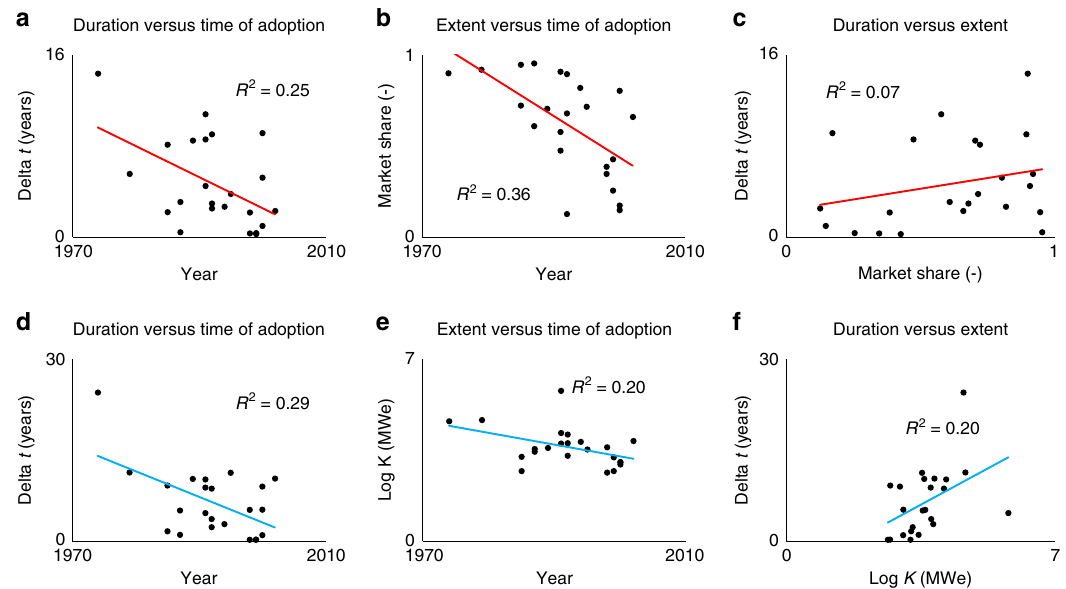
Fig. 4 The relationships between duration, extent and time of adoption of FGD. a – c show the relationships for the diffusion of FGD measured in terms of market share. d – f show the relationships for the diffusion of FGD measured in absolute capacity. Source data are provided as a Source Data fi